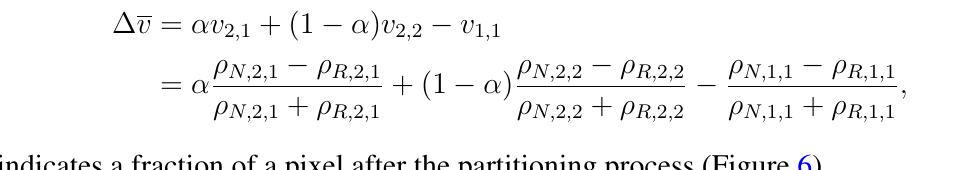
Figure 4. The endmember abundances of the vegetated surface (fraction of vegetation cover) for pixel k under the j -th resolution is represented by !